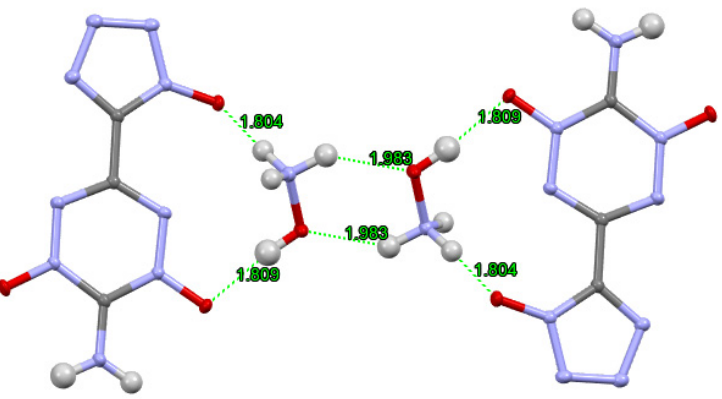
Figure 6. Hydroxylammonium-linked H-bonded dimers of 11 . The values of the bond lengths are given in angstroms.